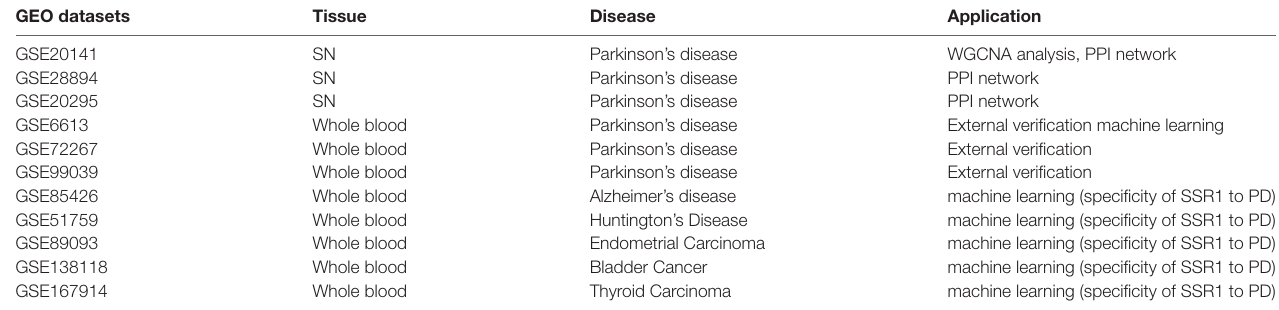
TABLE 1 | The information of Gene Expression Omnibus (GEO) datasets. GEO